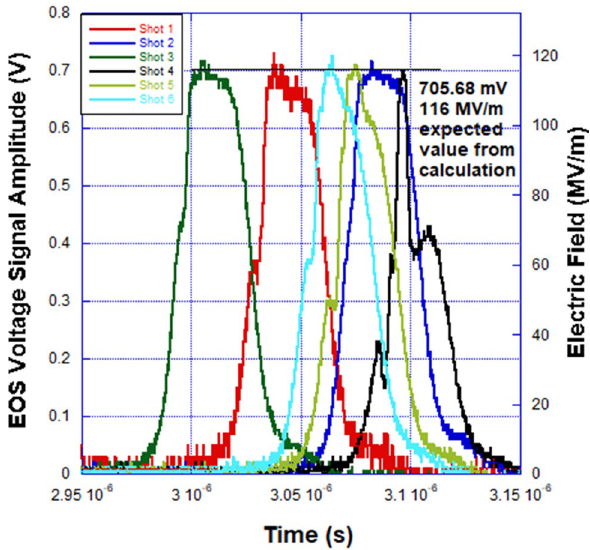
Figure 4. EOS signal amplitude versus time for a series of six shots on the HERMES III pulsed power accelerator. The average peak pulse amplitude and electric field were 715.66 mV and 117.86 MV/m compared to the expected values of 705.68 mV and 116 MV/m from the calculation. The average pulse width (excluding shot #4) for the EOS signals was 33.30 ns.